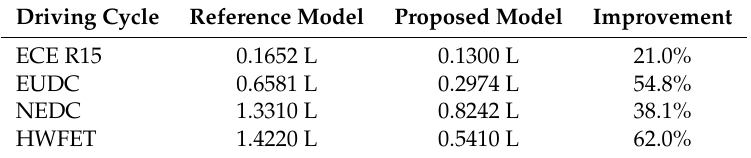
Table 6. Fuel consumed comparison between reference and proposed model in [42].